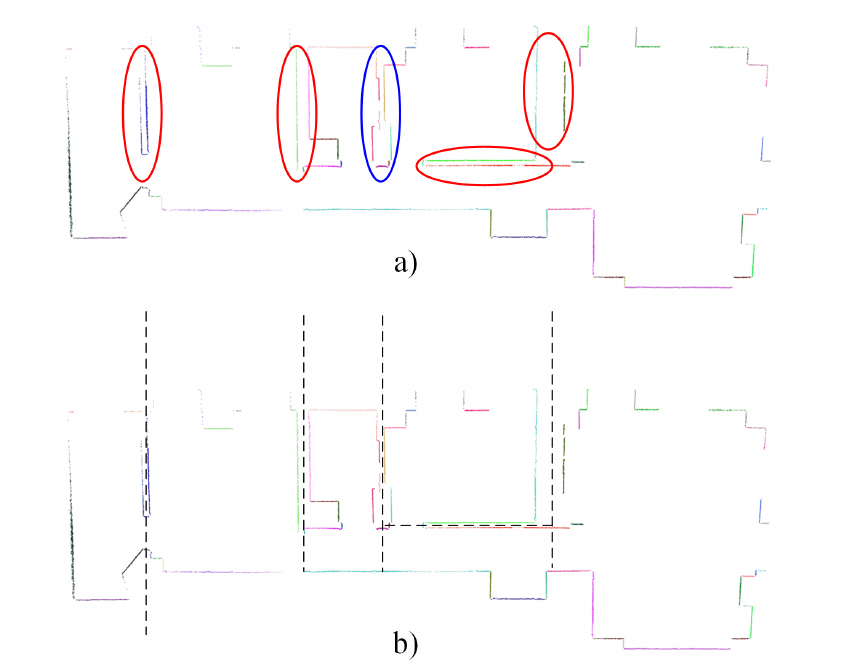
Figure 12. The division process of 2D layer: ( a ) The localization of inner walls (blue circle: wall in multiple labels; red circle: Wall in the individual label), and ( b ) the layer division according to the inner wall